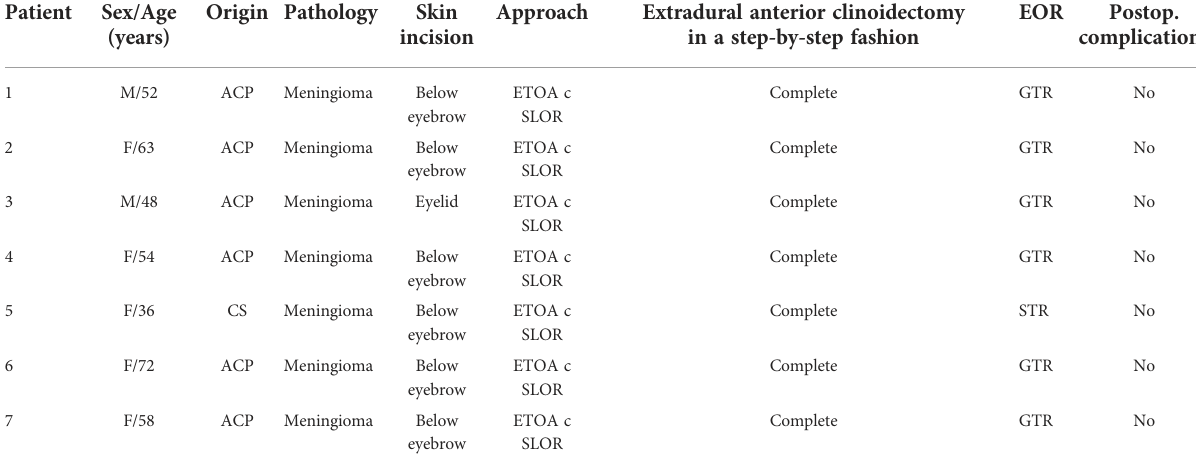
TABLE 1 Clinical and demographic characteristics of patients who underwent stepwise endoscopic transorbital extradural anterior clinoidectomy.